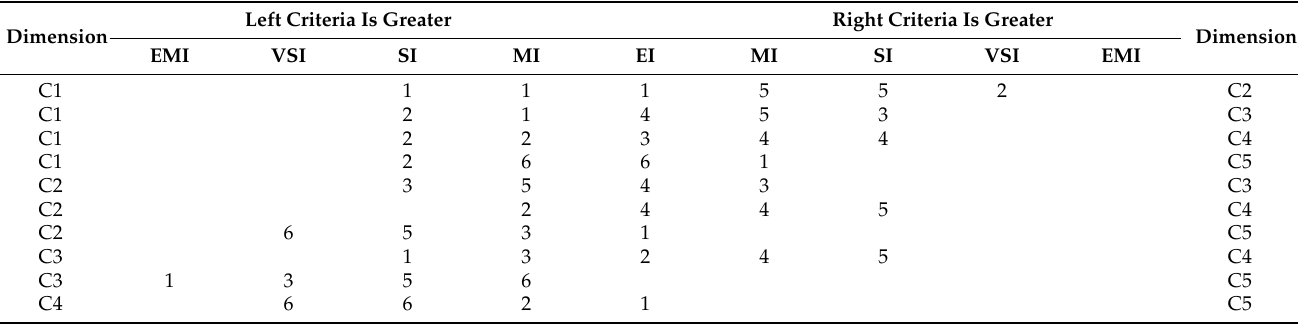
Table 5. The initial comparison matrix of